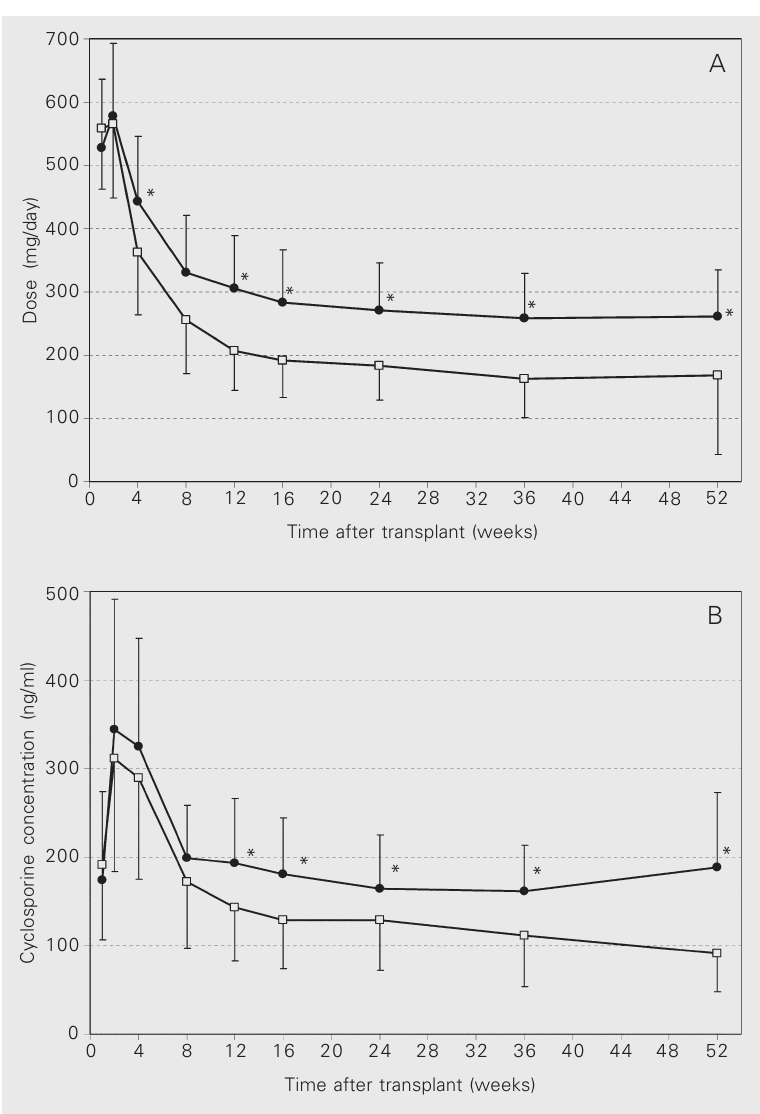
Figure 1. Mean cyclosporine daily doses (A) and trough whole blood concentrations (B) in patients receiving sirolimus (squares) or azathioprine (circles). *P < 0.05 comparing mean values at each time of transplant (unpaired Student t